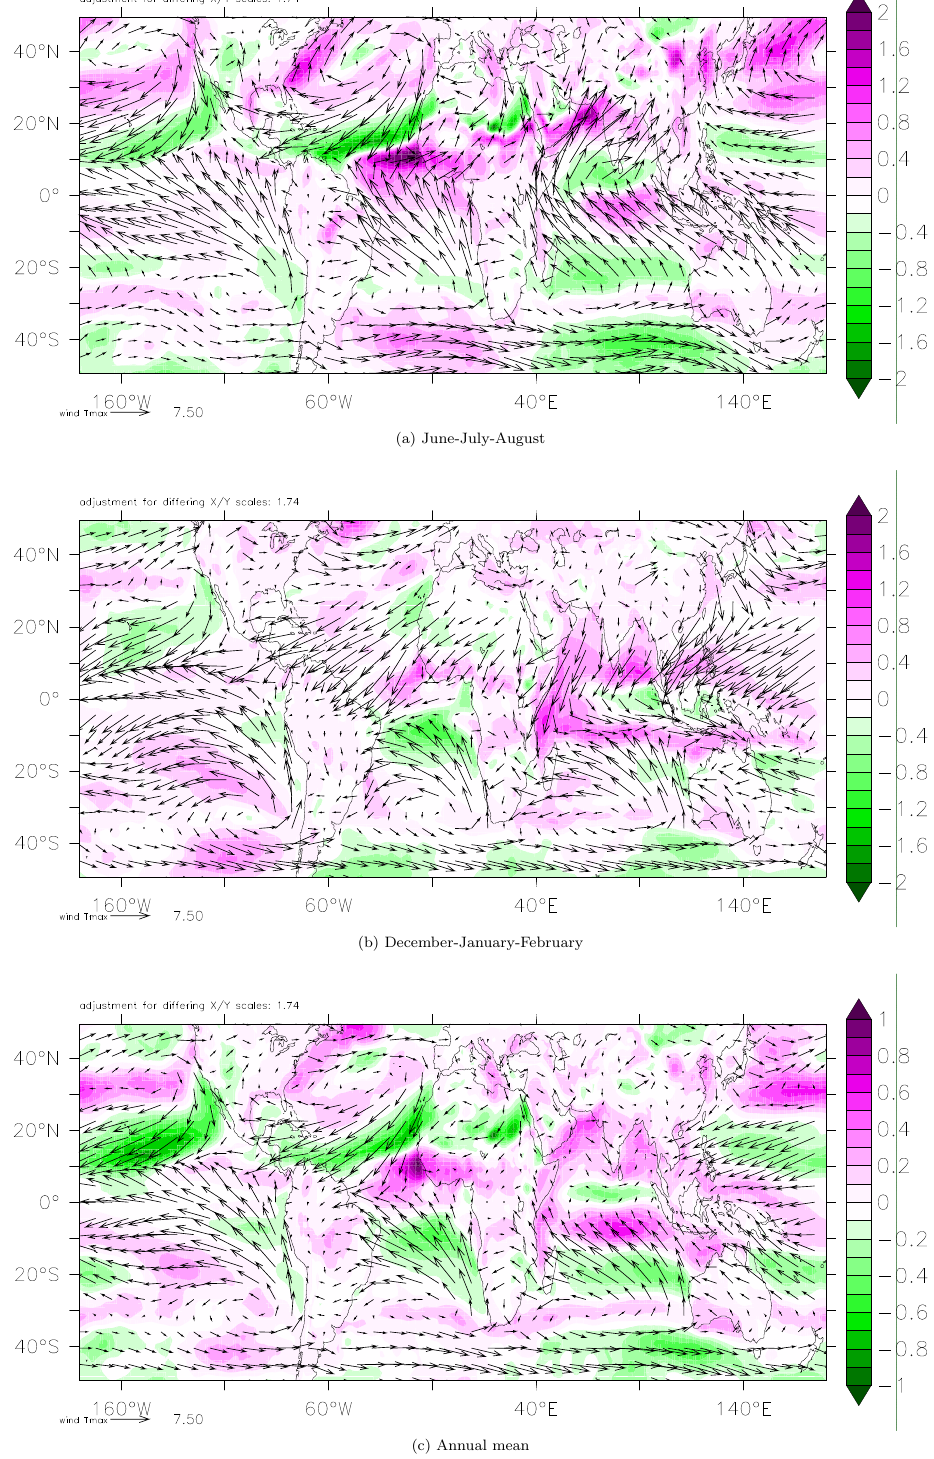
Figure 5. Wind during T max for JJA (a) , DJF (b) and the annual mean (c) , in ms − 1 . The colour scale indicates the difference in wind speed between T max and T min , in ms − 1 . Note the different colour scale for the annual mean. Every ninth vector is shown in the x direction, and every fifth in the y